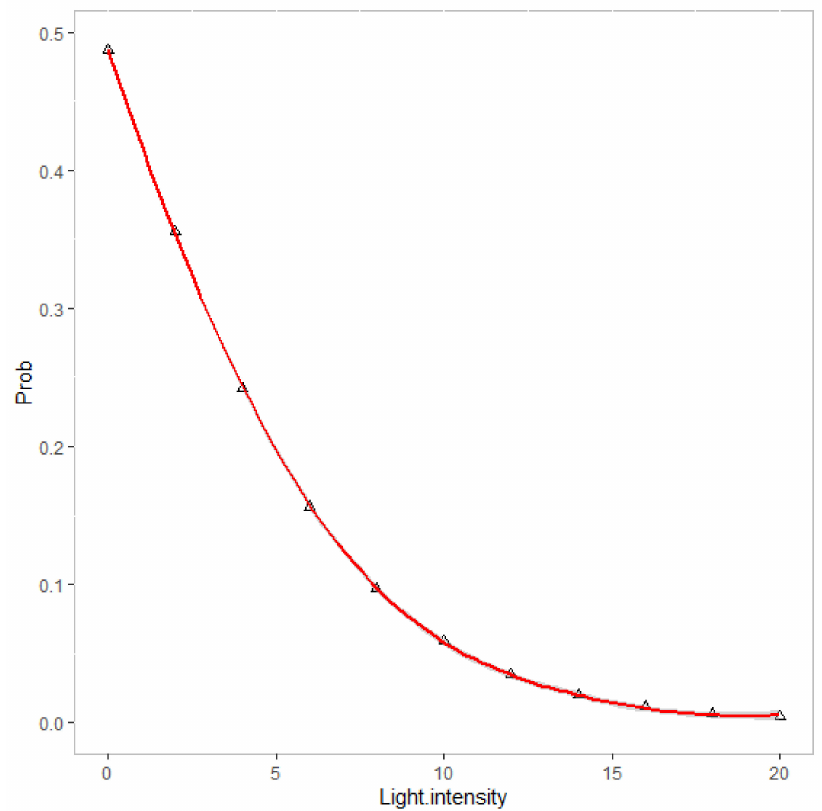
Figure 4. Prediction of the relationship between the probability of swimming behavior and light intensity based on a generalized linear